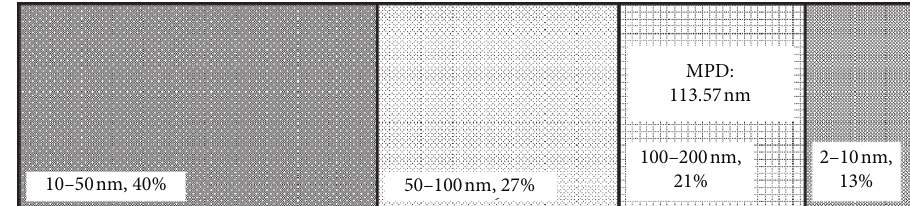
Figure 9: Pore volume proportion of NCG concretion in various pore-diameter ranges by BET test.